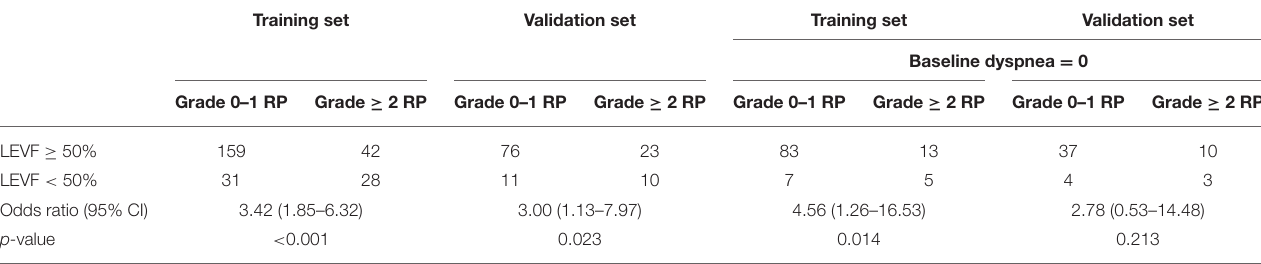
TABLE 3 | Comparison of the risk of radiation pneumonitis between LVEF ≥ 50% and < 50%. Training